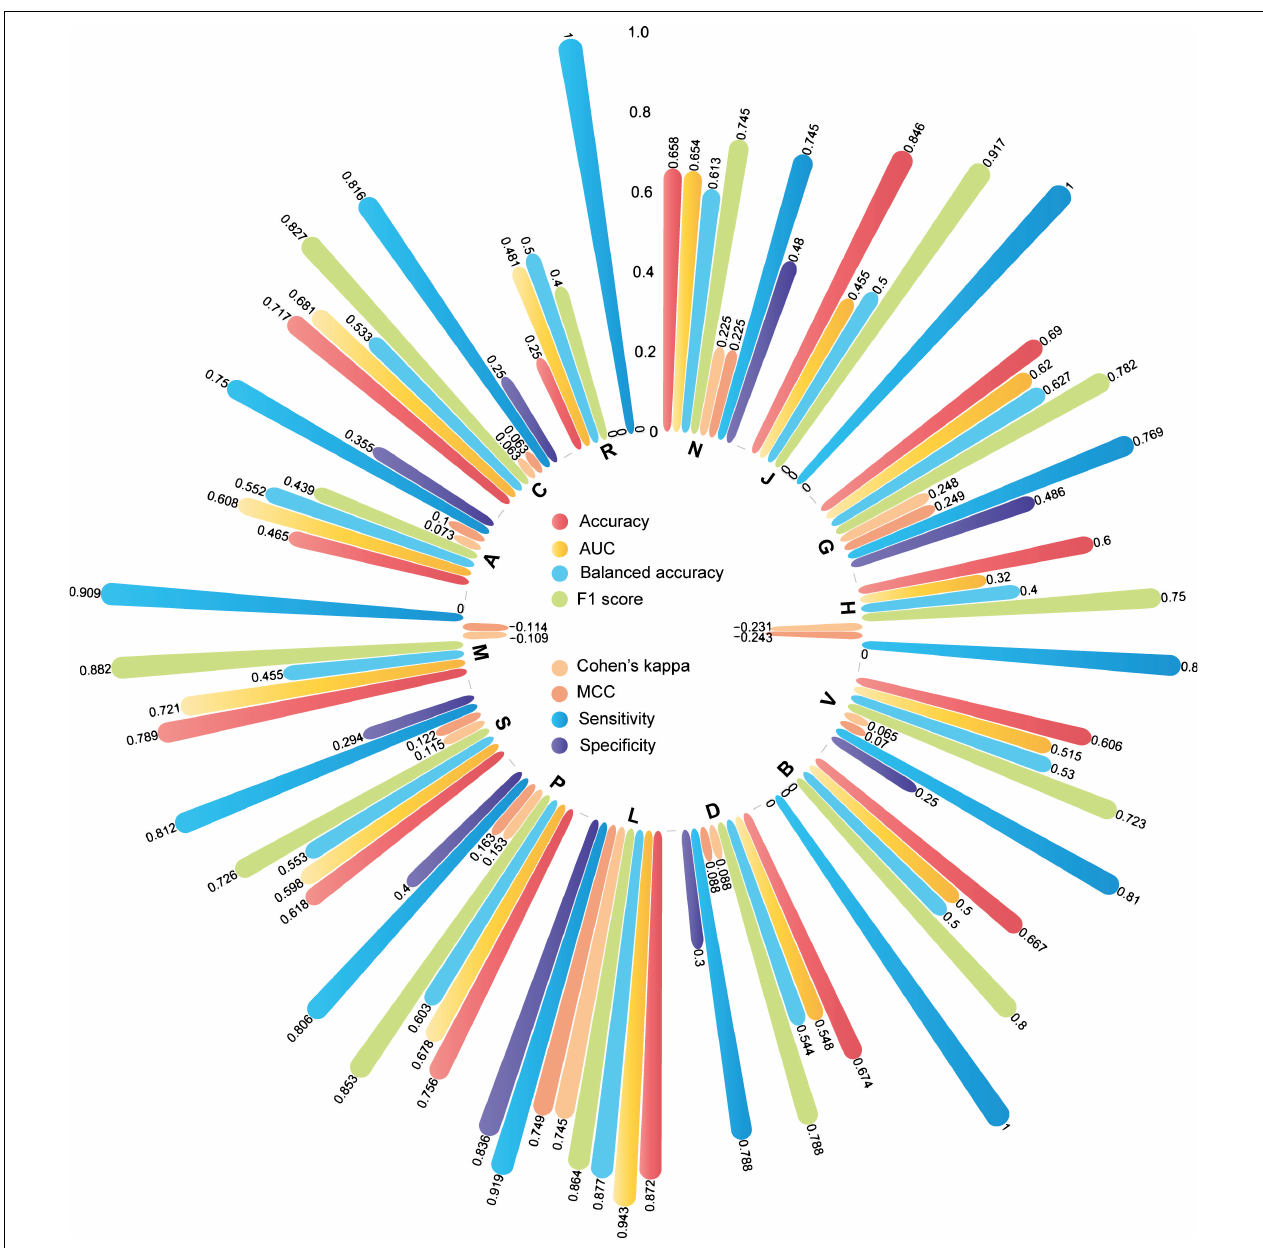
FIGURE 6 | The model performance for the individual therapeutic class according to the first level of the WHO ATC codes.